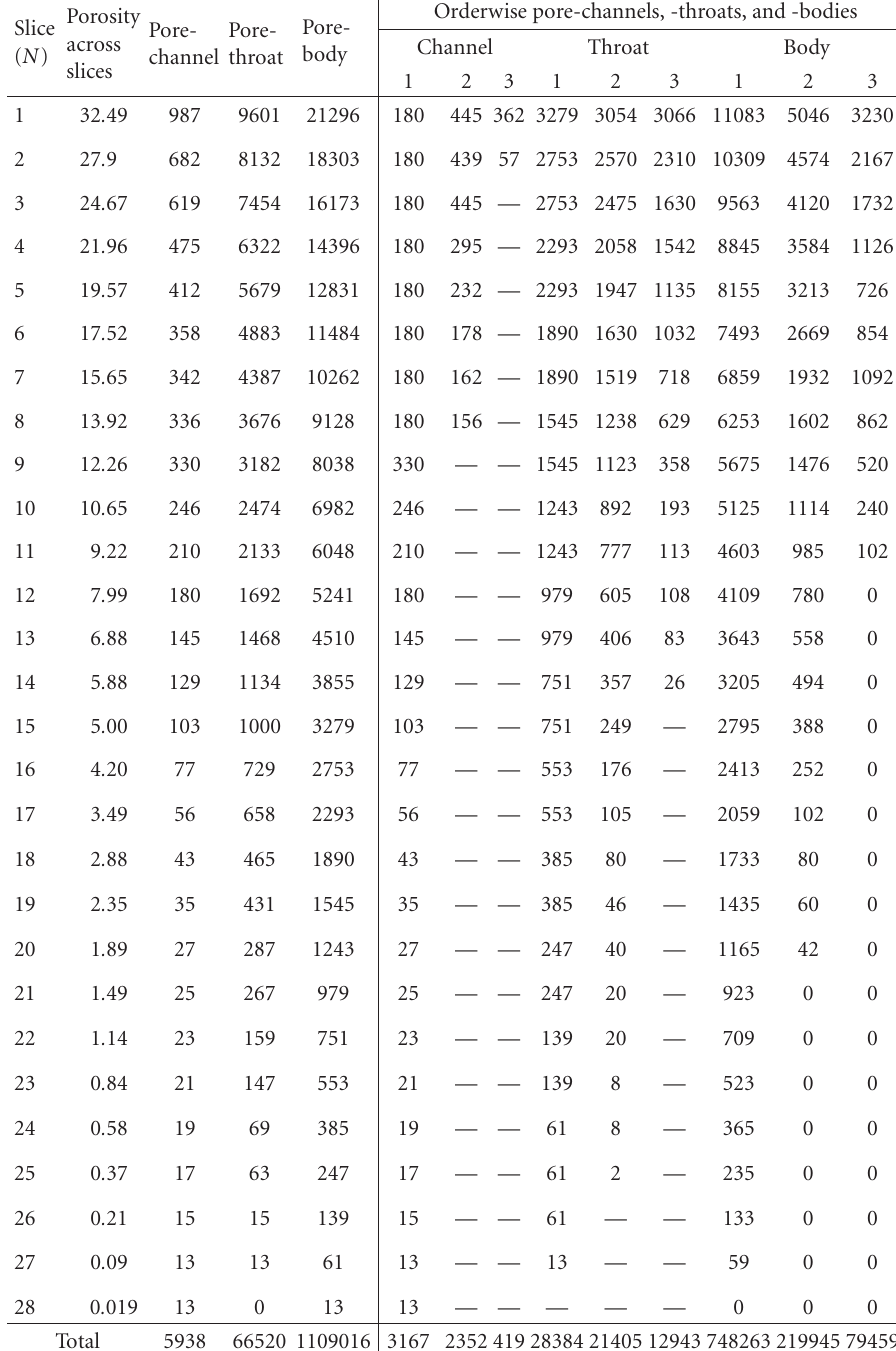
Table 4.1. Orderwise number of pixels at each slice of fractal pore-channel, -throat, and